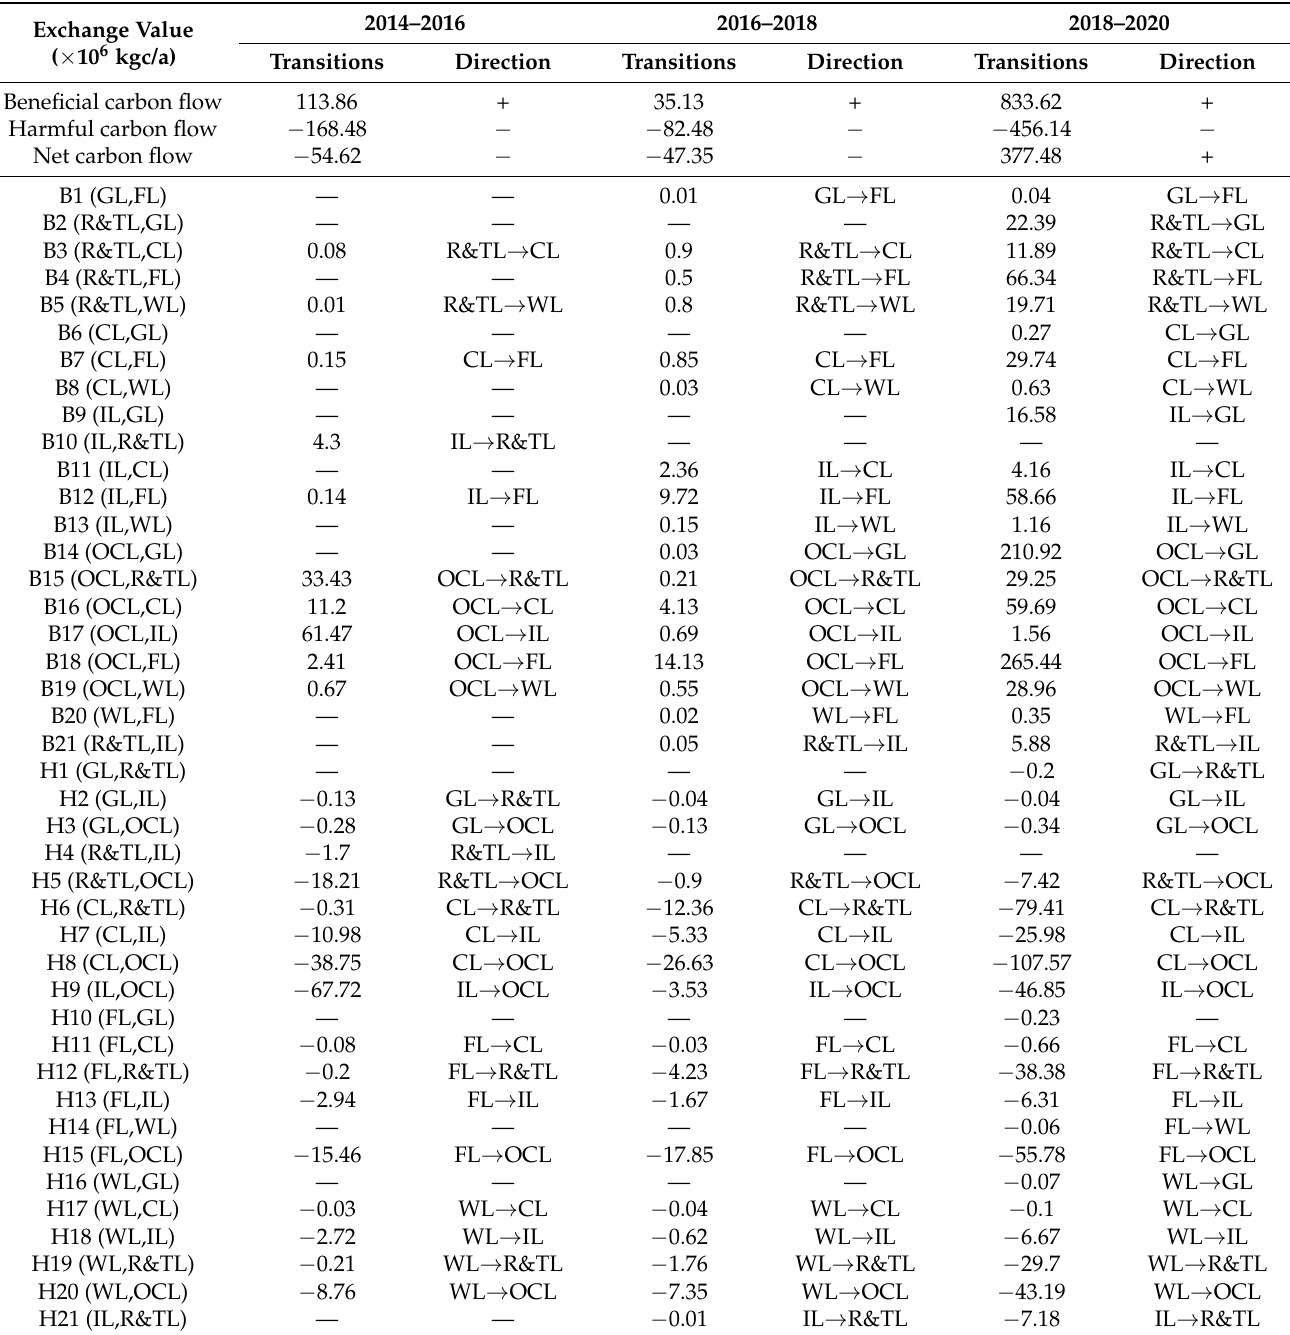
Table 4. Exchange of carbon